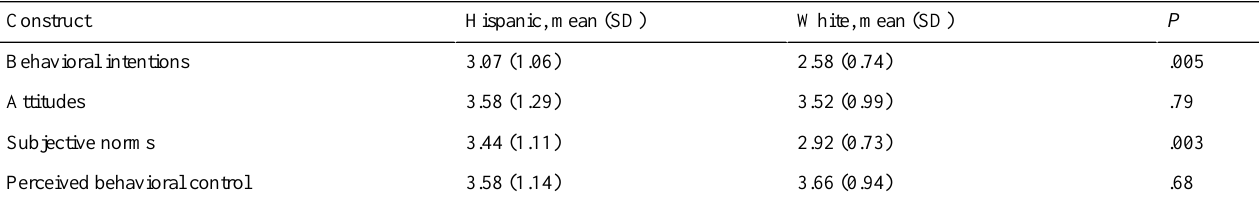
Table 4. Mean scores of behavioral constructs for Hispanic and white participants (N=189).